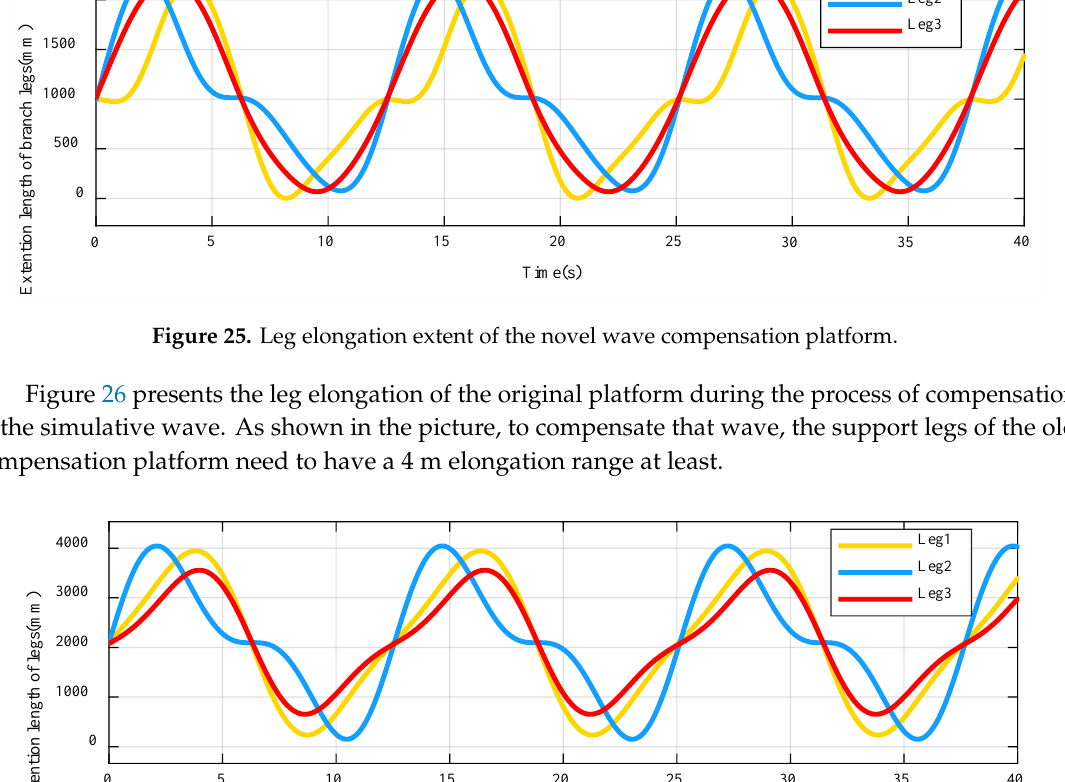
Figure 26. Leg elongation extent of the original wave compensation platform.